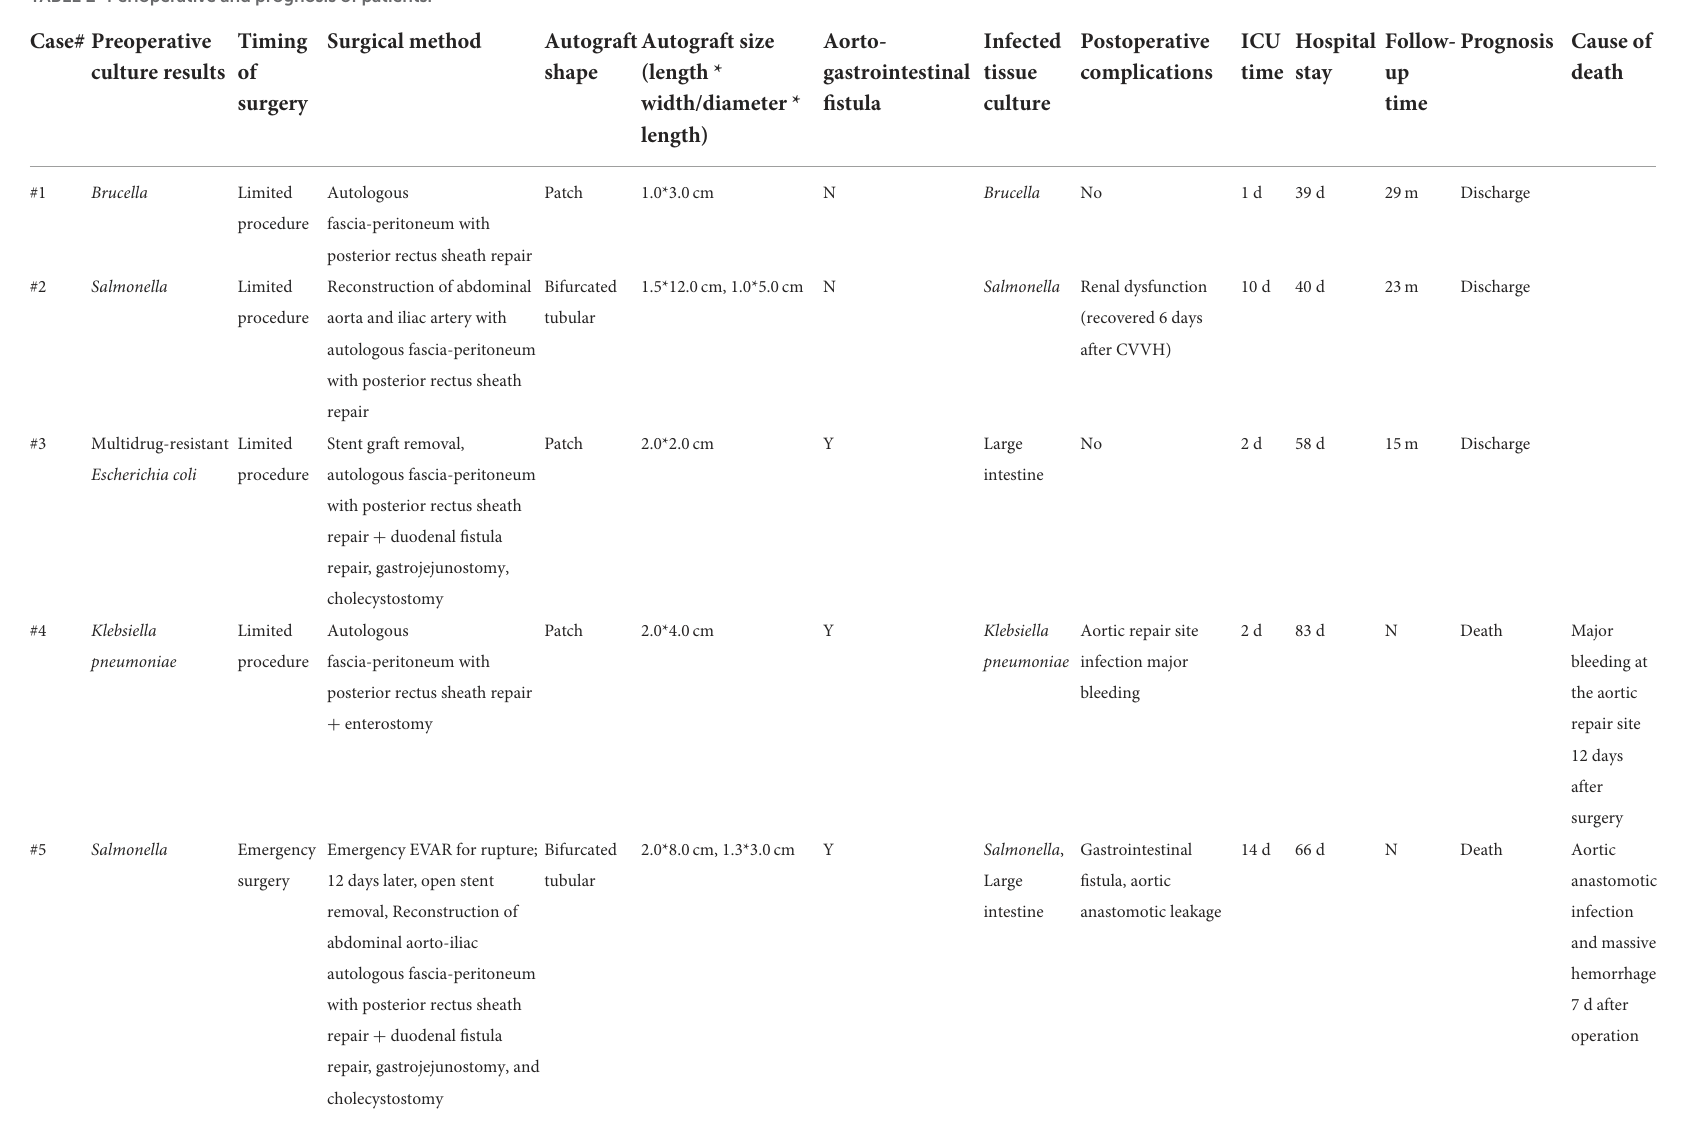
TABLE 2 Perioperative and prognosis of